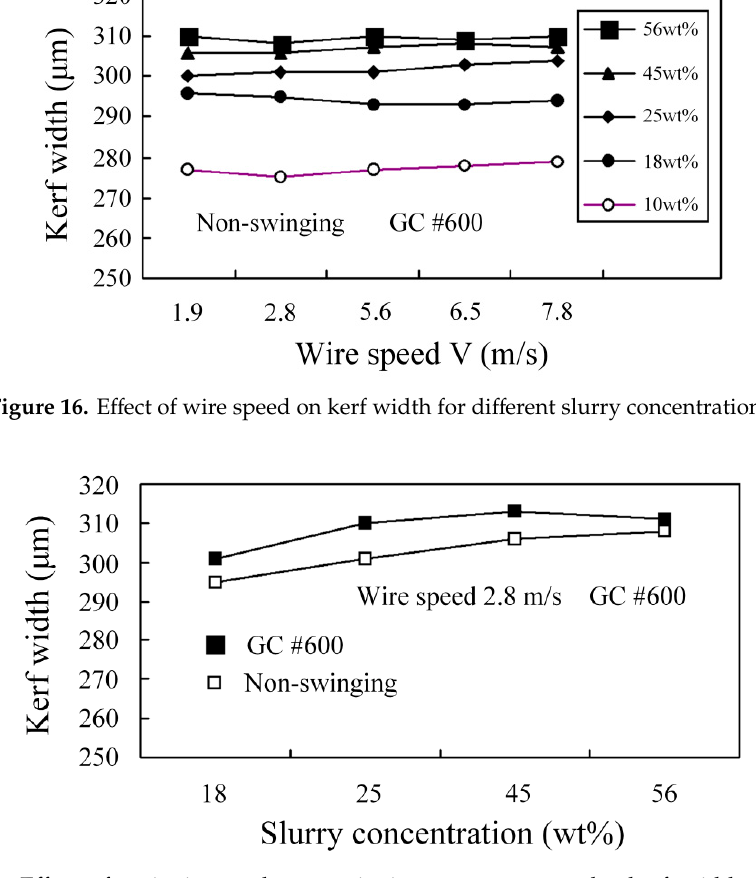
Figure 17. Effect of swinging and non-swinging processes on the kerf width for different slurry concentrations.